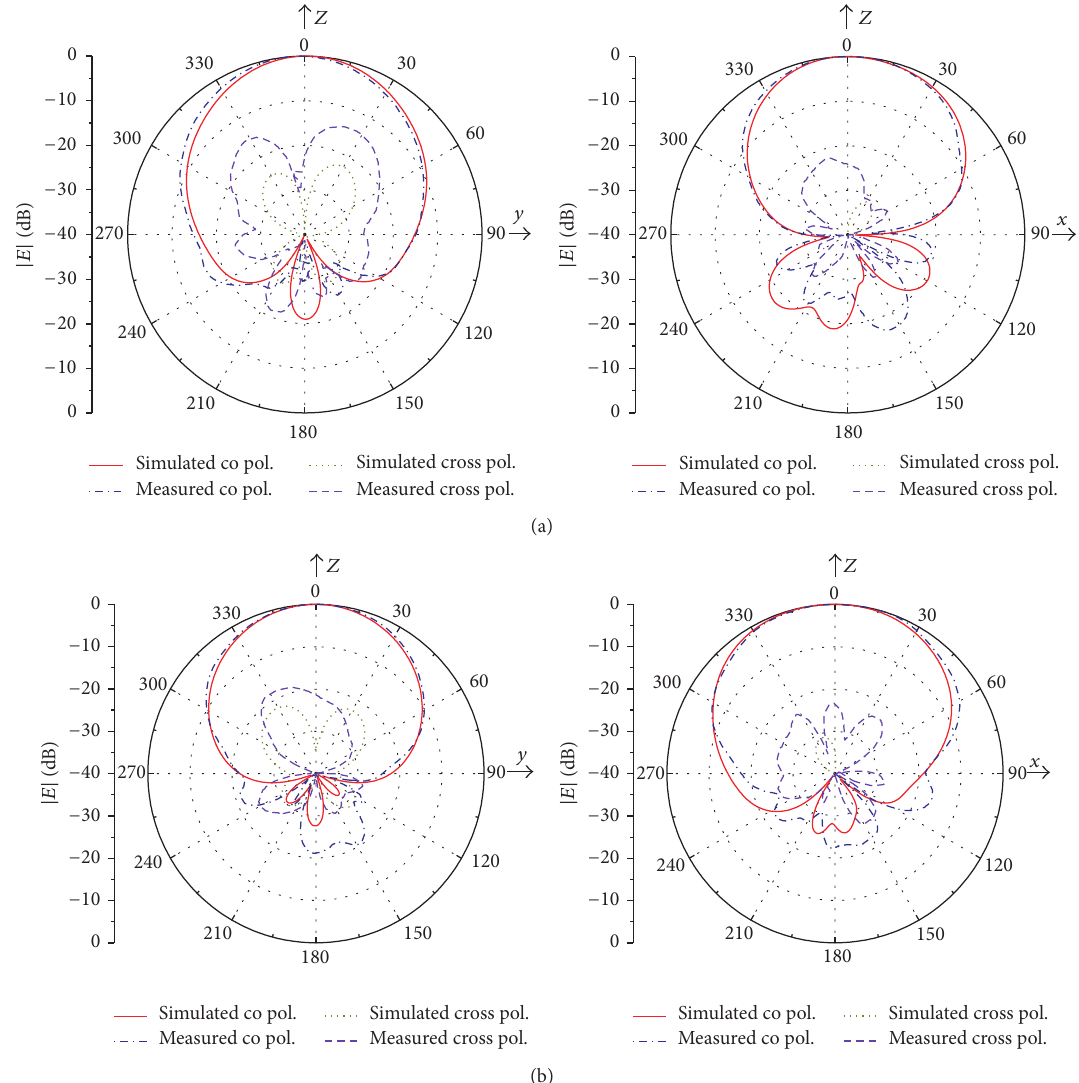
Figure 3: Radiation patterns of the V/H dual-polarized antenna at 2.2 GHz: (a) VP and (b)